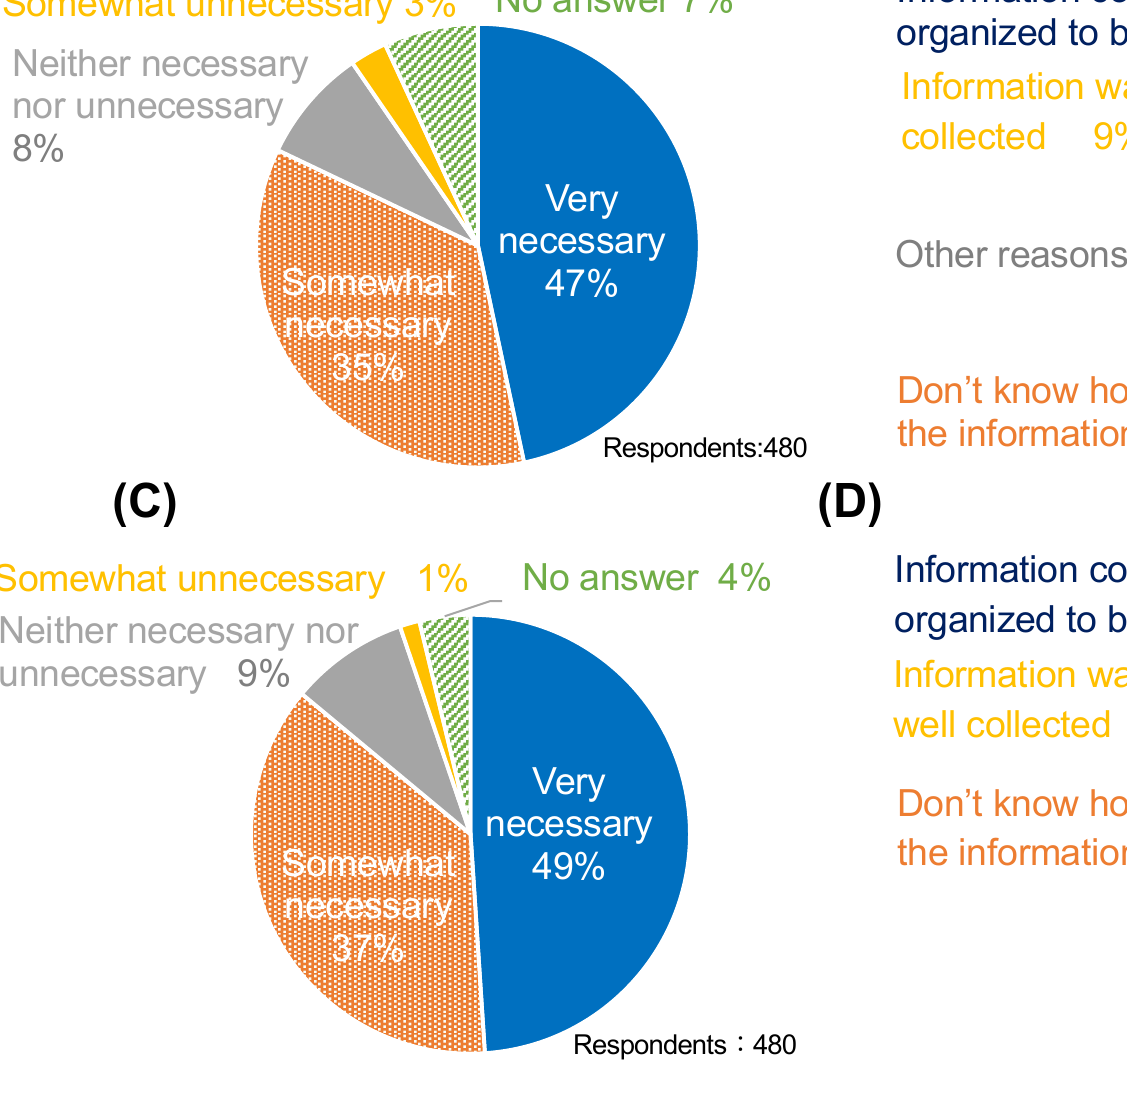
Appendix 6 Awareness of the importance of traditional and local knowledge in LBSAPs, and reasons for which traditional and local knowledge was not used in LBSAPs. A high degree of awareness existed regarding the importance of incorporating traditional knowledge (A) or local knowledge (C) into LBSAPs. The lack of information or limited understanding was often expressed as reasons for not using traditional knowledge (B) or local knowledge (D) in